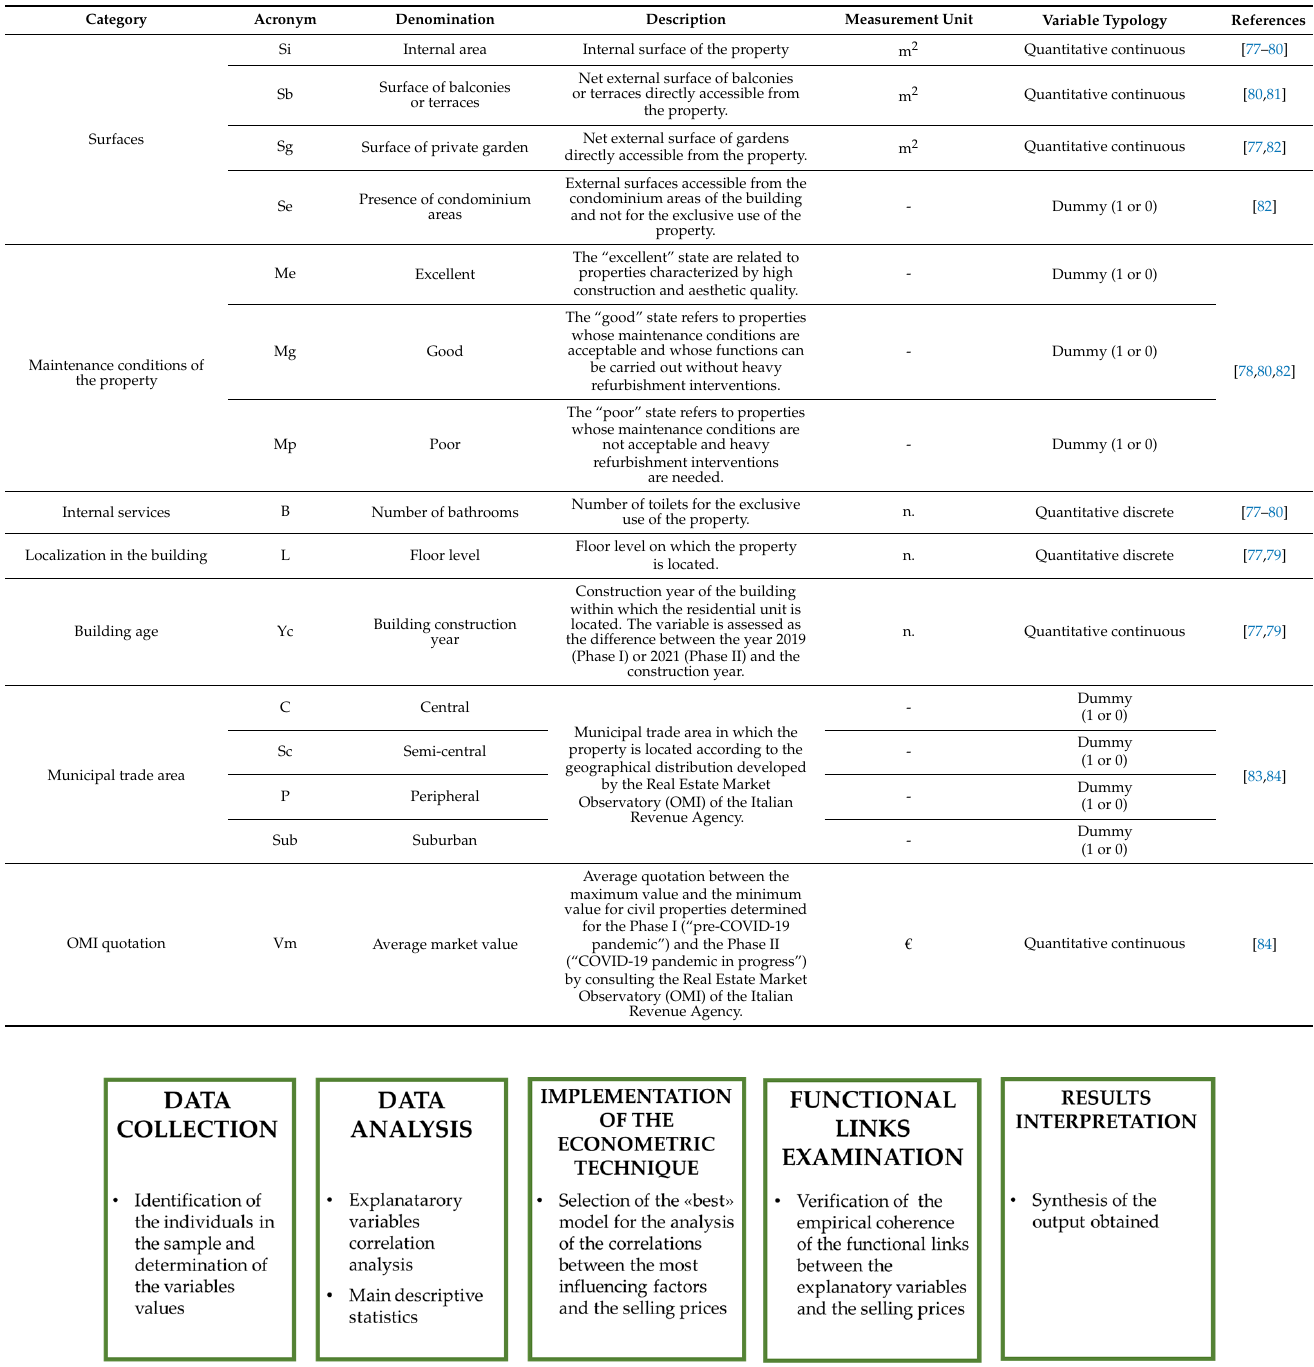
Table 2. Variables selected in the analysis.